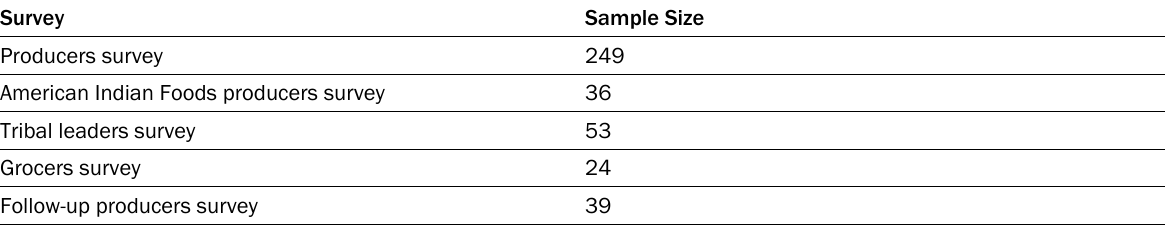
Table 1. Surveys Administered to IAC